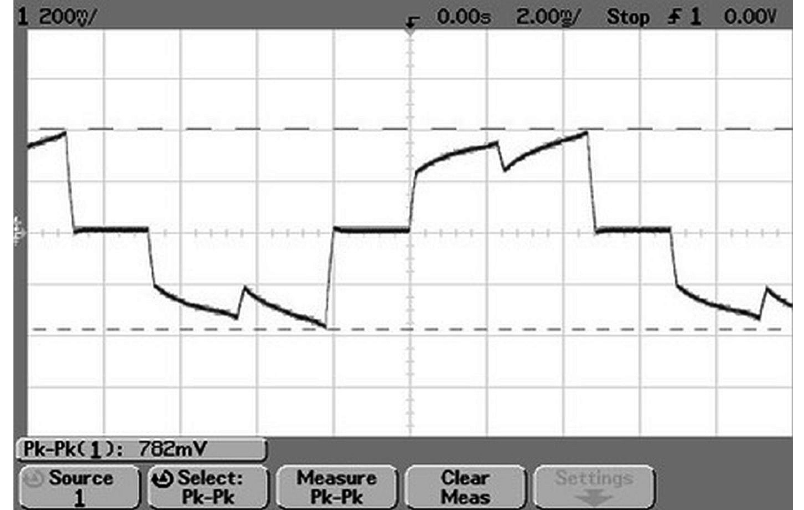
Figure 12. Constant torque region experimental results: motor phase current waveform (10 A/div, 2 ms/div).